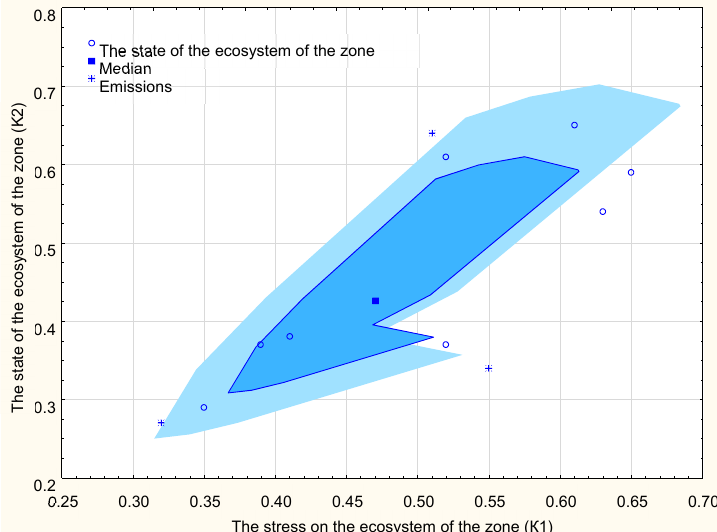
Figure 3. Criterion concentration chart К 1 – К 2 “Industrial zone ecosystem load—Industrial zone ecosystem state”.